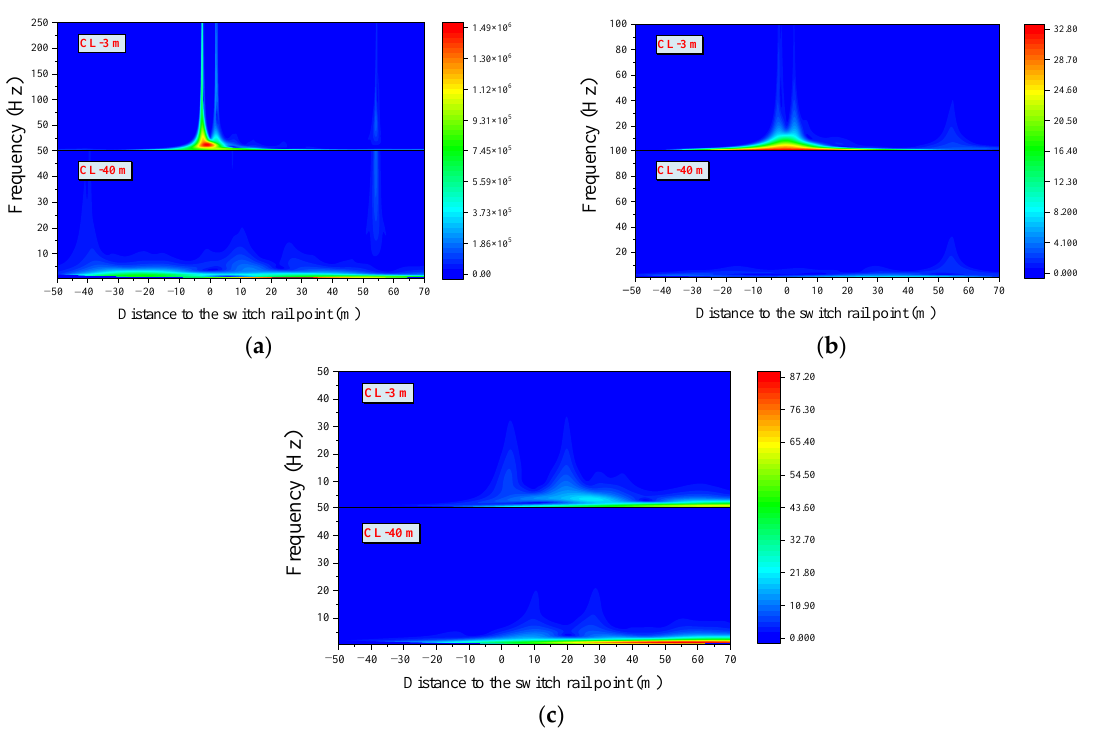
Figure 17. Time-frequency graphs of dynamic indicators at the CL in front of the turnout: ( a ) Wheel- rail vertical force; ( b ) wheel unloading rate; ( c ) Lateral acceleration of the vehicle body.